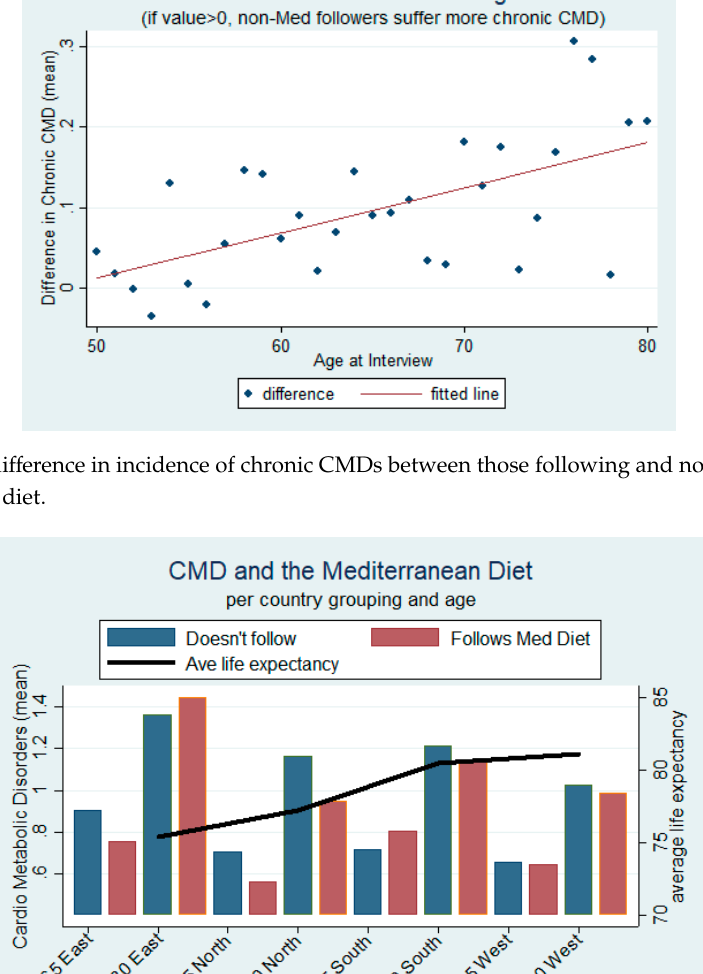
Figure 2. The difference in incidence of chronic CMDs between those following and not following the Mediterranean diet.